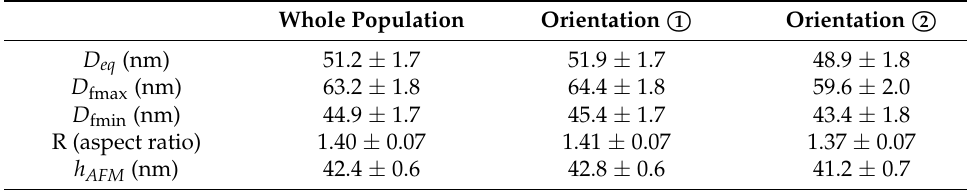
Table 4. Different descriptors as determined for each population of TiO 2 NPs. Whole